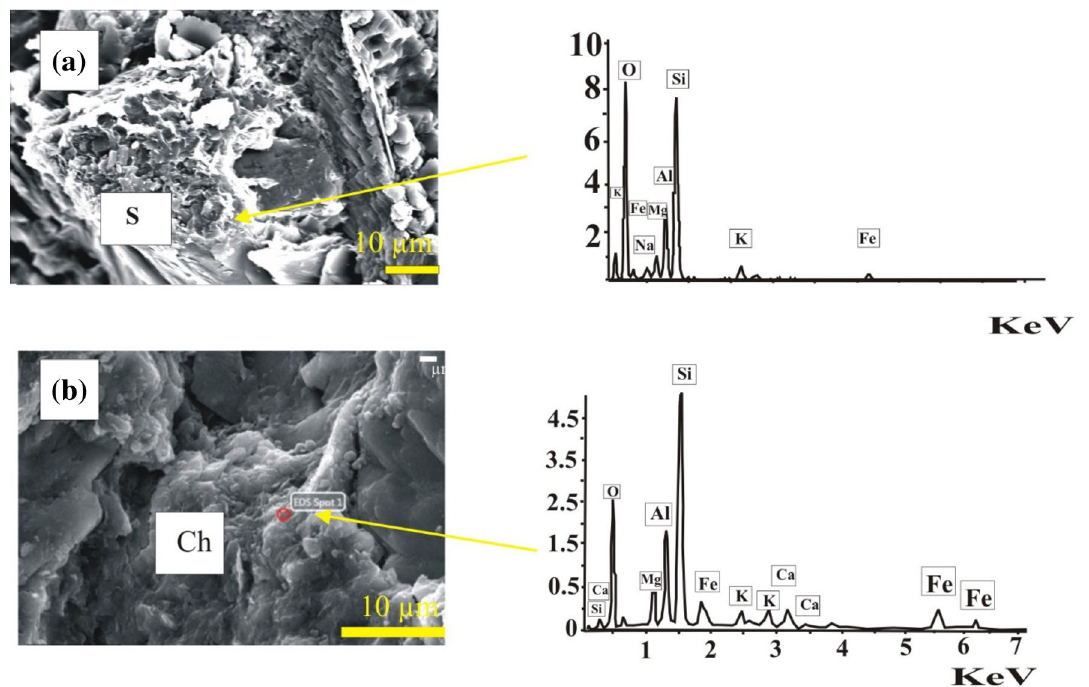
Fig. 9 Representative SEM micrographs and EDS traces for Hay- mana sandstones samples a Diagenetic smectite minerals (S) have observed as pore filling. Pore throats are commonly filled with authi- genic clays, creating microporosity (pores with diameter < 1.5–2